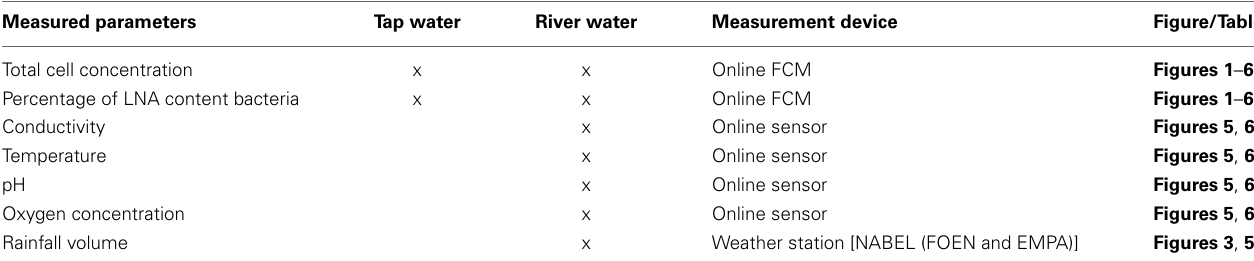
Table 1 | Overview of measured parameters and employed measurement devices for each water